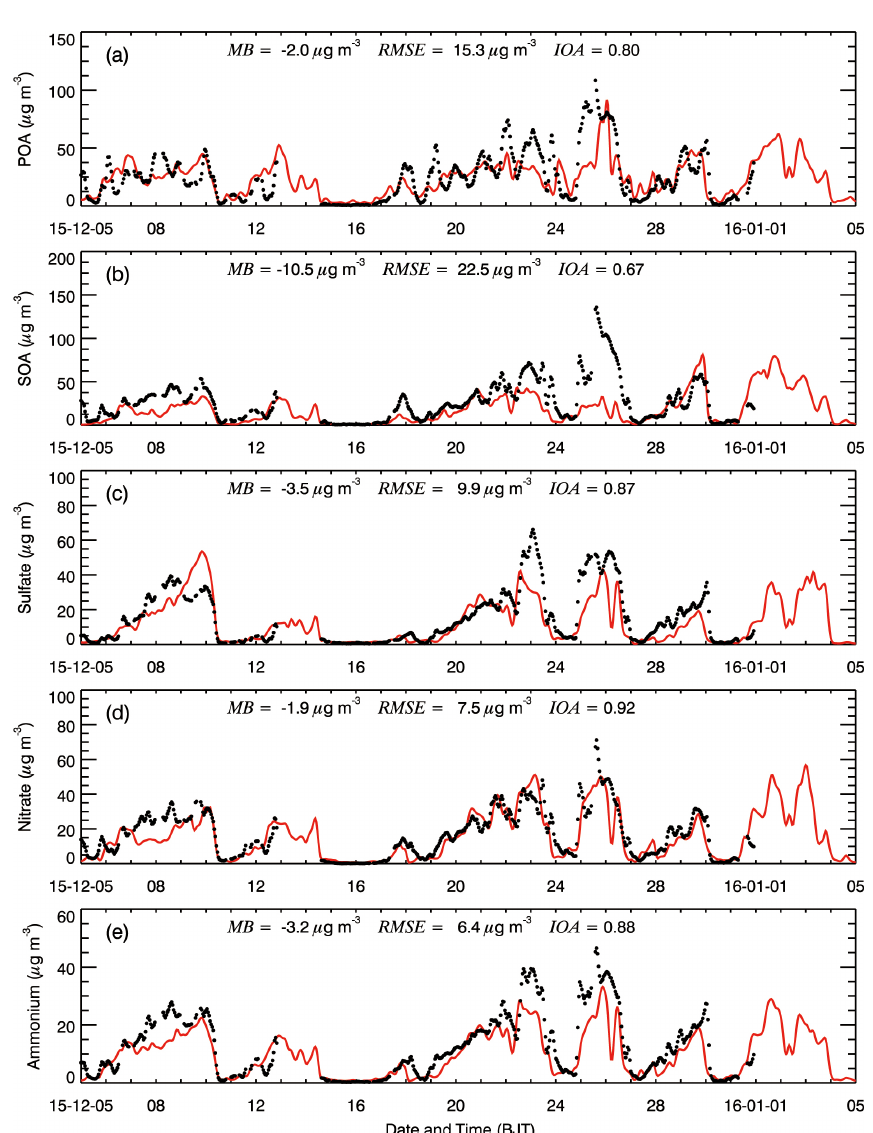
Figure 4. Comparison of measured (black dots) and simulated (black line) diurnal profiles of submicron aerosol species of (a) POA, (b) SOA, (c) sulfate, (d) nitrate, and (e) ammonium at the NCNST site in Beijing from 5 December 2015 to 4 January